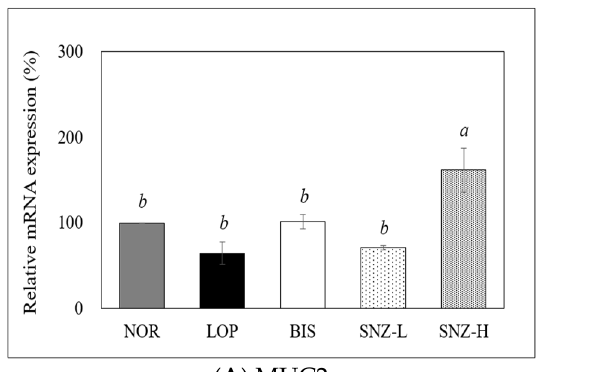
( E ) SNZ-H Figure 4. Effects of B. coagulans SNZ 1969 on mucous secretion capacity in loperamide-induced con- stipation rats. ( A ) NOR: Normal group, ( B ) LOP: Loperamide treated group, ( C ) BIS: Loperamide and Bisacodyl 8 mg/kg treated group, ( D ) SNZ-L: Loperamide and B. coagulans SNZ 1969 at 1 × 10 8 CFU/day treated group, ( E ) SNZ-H: Loperamide and B. coagulans SNZ 1969 at 1 × 10 10 CFU/day treated group. Magnification 200×. Scale bar = 50 μ m.